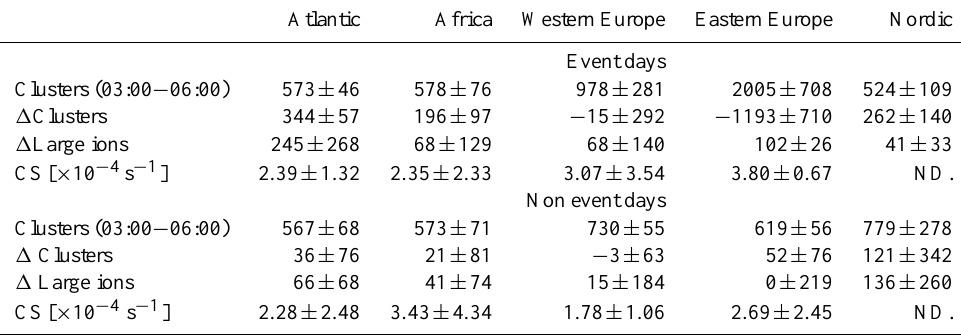
Table 3. Comparison of positive ion concentrations for event and non event days. Concentrations are given in [# / cm − 3 ], 1 Clusters and 1 Large ions are computed respectively between (09:00–12:00) and (03:00–06:00), and, (15:00–18:00) and (03:00–06:00) LT. CS values are given for clear sky